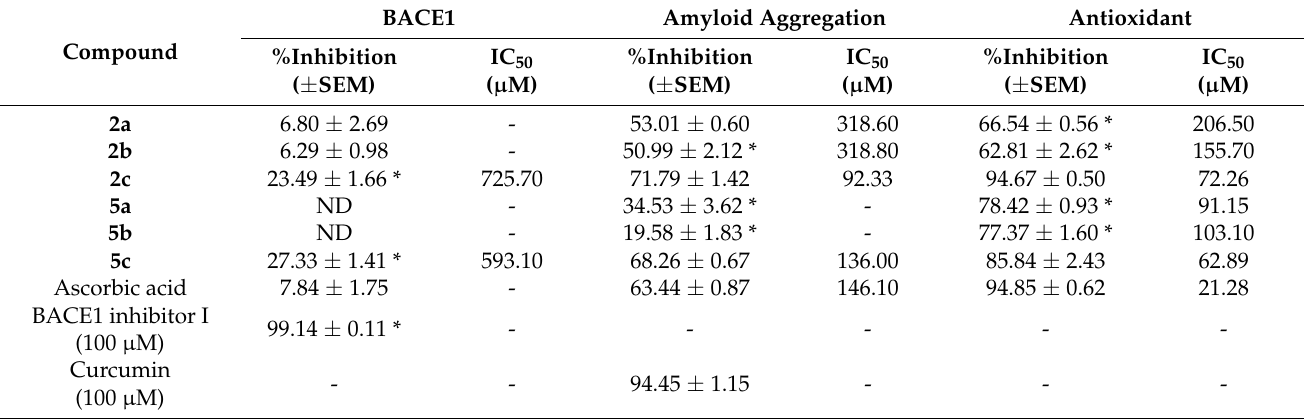
Table 1. Multifunctional in vitro activities of ascorbic derivatives at a concentration of 400 µ M.